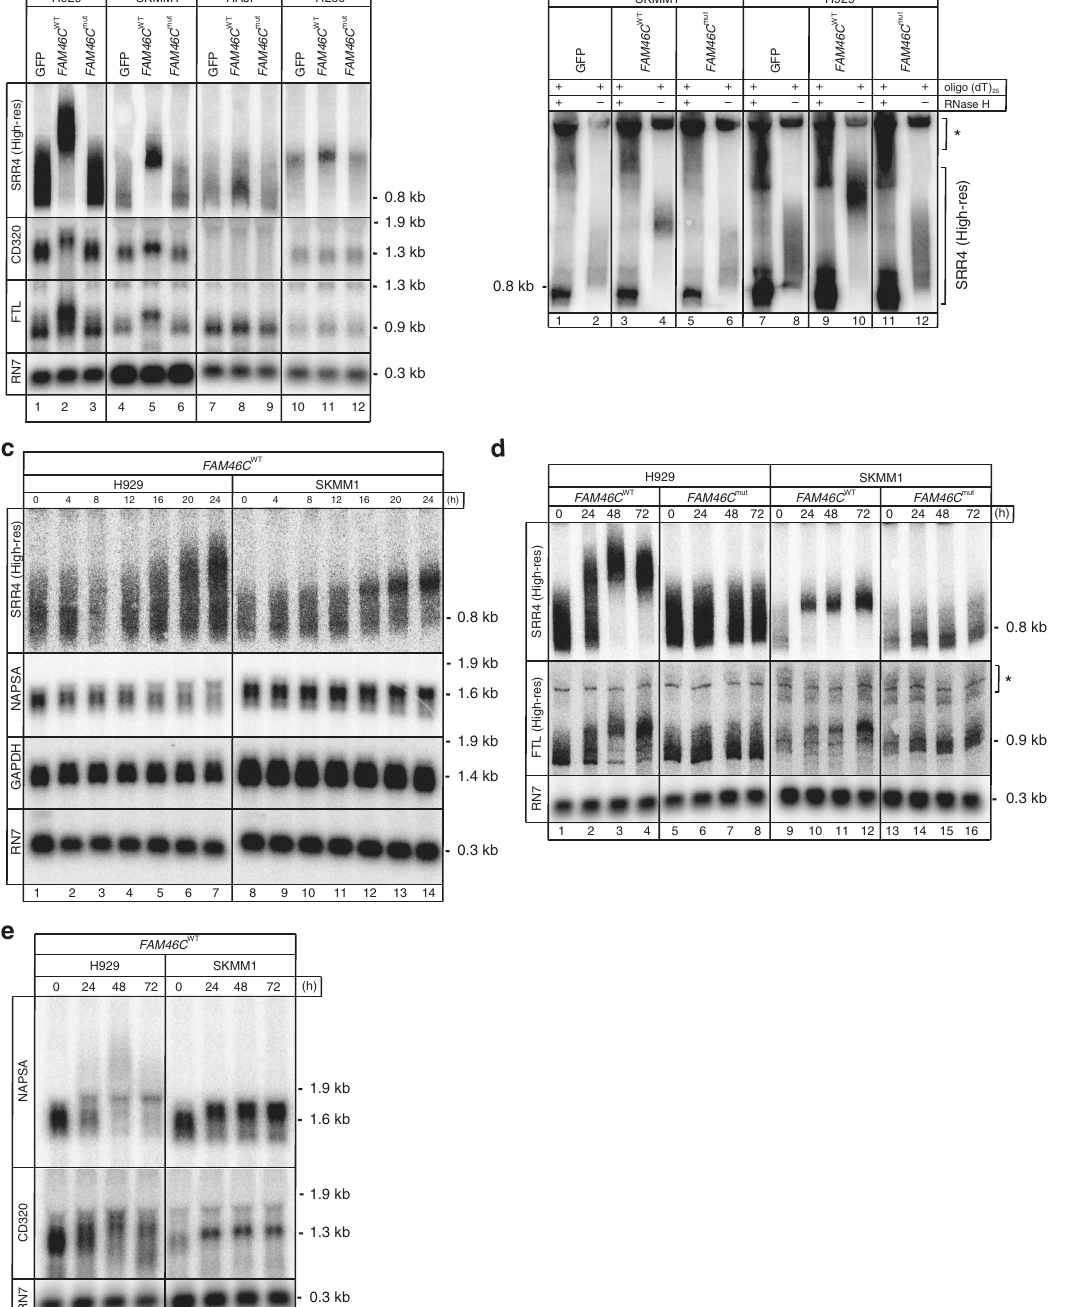
NATURE COMMUNICATIONS | 8: